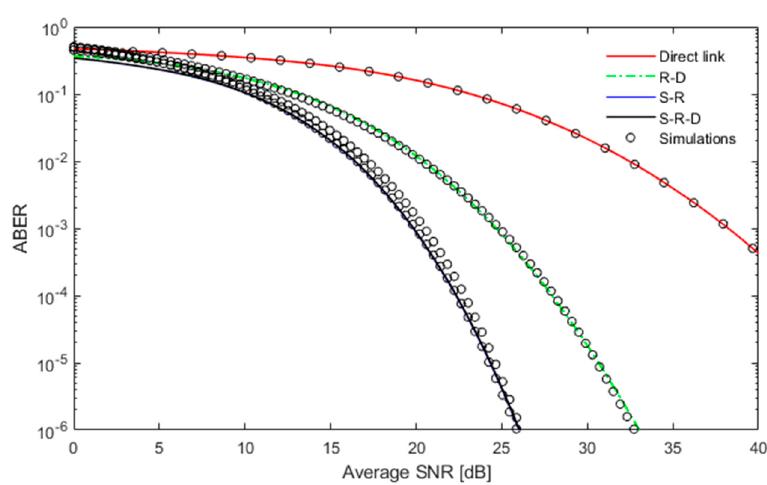
Figure 7 ABER vs. SNR of FSO over L ‐ N channel for moderate turbulence with distance 600–400 m, the Figure 7. ABER vs. SNR of FSO over L-N channel for moderate turbulence with distance 600–400 m, number of relays = 3, and w z = 2m. the number of relays = 3, and w z = 2